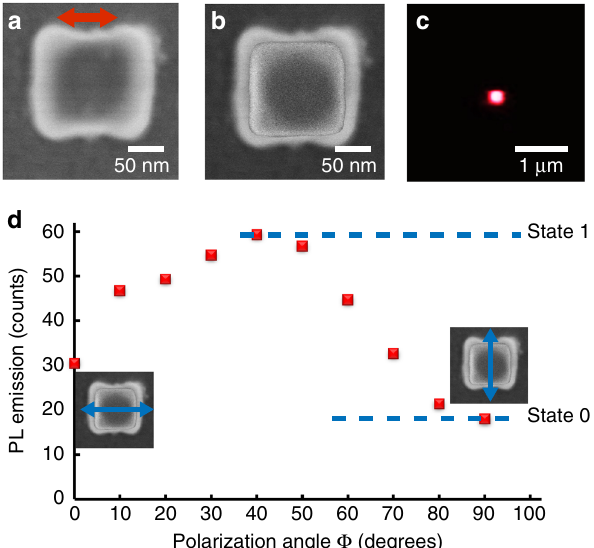
Fig. 4 Photoluminescence measurements on single hybrid nano-emitters. Hybrid nanosource based on Au nanocube and CdSe/CdS/Zn quantum dots embedded in polymerized volumes obtained under exciting polarization along the cube edge side (red arrow). a Raw SEM image of the hybrid nanosystem. b SEM raw image with superimposed initial bare nanocube. c Far- fi eld PL image at ϕ = 0° polarization angle, λ = 405nm, linear polarization. d PL intensity as a function of the angle of polarization ϕ of the blue exciting beam. Blue arrows indicate two speci fi c perpendicular